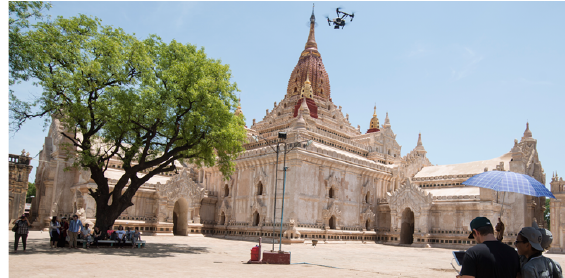
Figure 4: UAS device for mapping a heritage place, Ananda Temple (Bagan), Mario